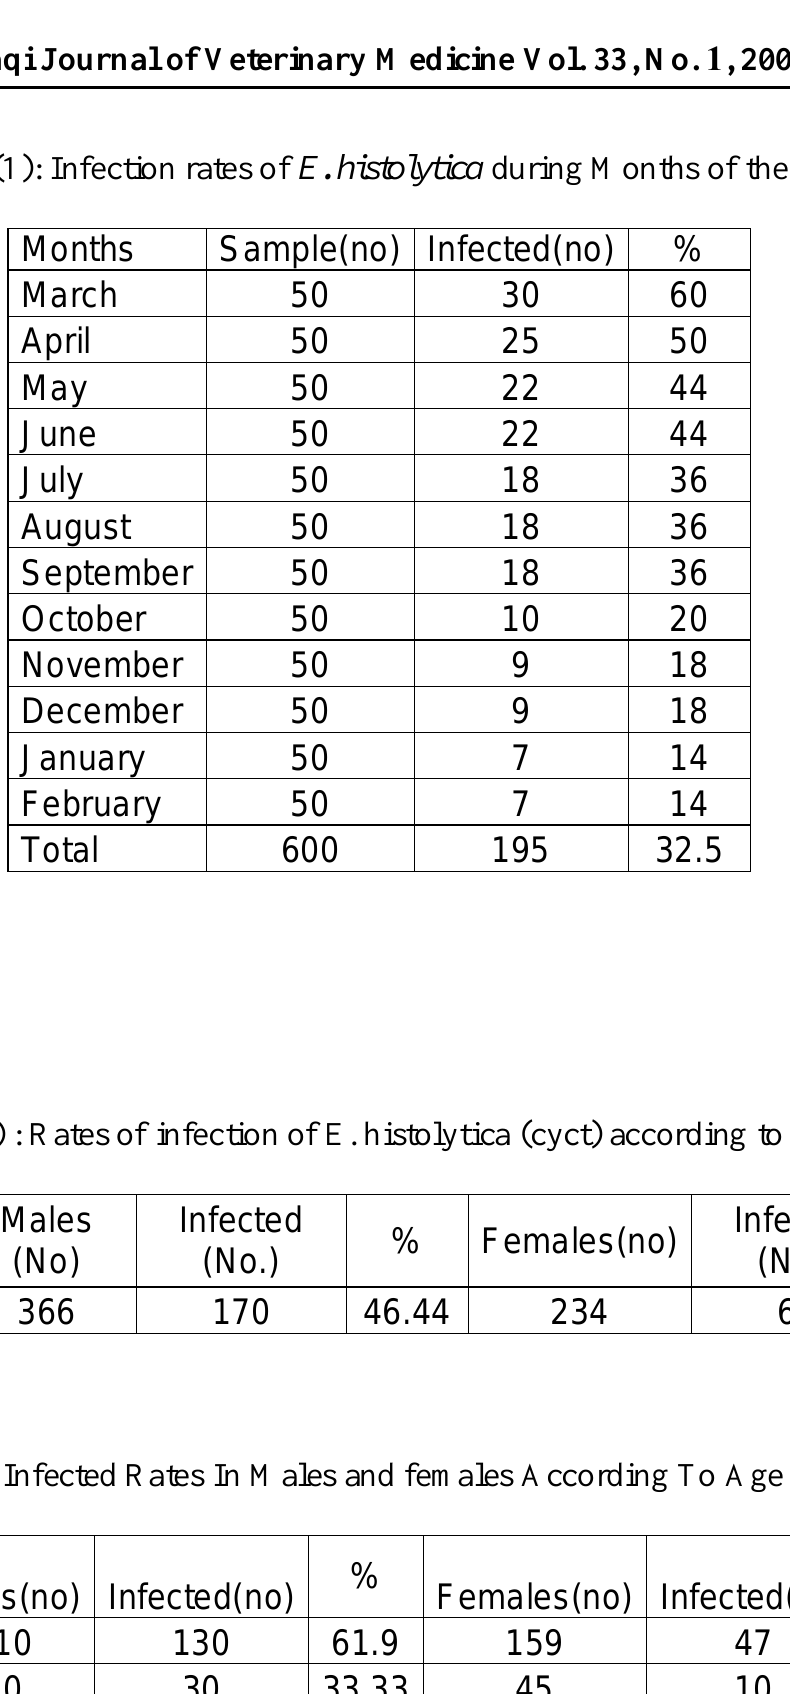
Table(3): Infected Rates In Males and females According To Age Groups Age groups males(no)